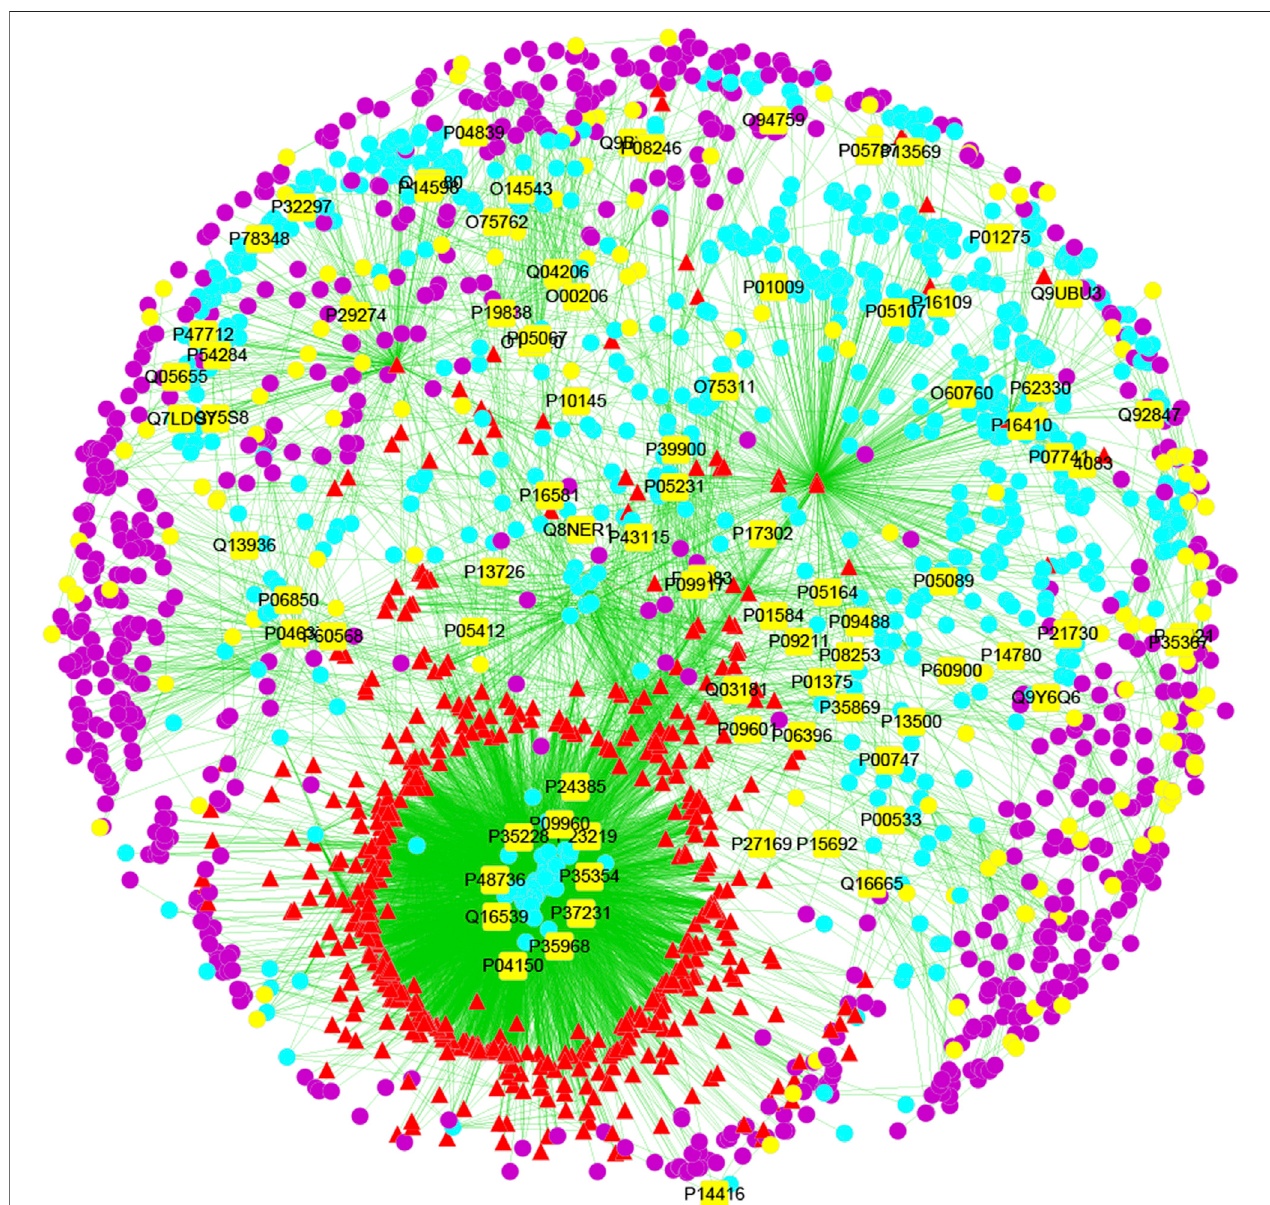
FIGURE 1 | The compound-target-disease interaction network of LHQWC for treating in fl ammation. The yellow square represents the joint target of drugs and diseases, which is also the most important direct target protein in treating in fl ammation by LHQWC. Yellow dots represent in fl ammatory targets. The red triangle represents the predicted possible active ingredients in LHQWC. The blue dot represents the target of LHQWC. The purple dots represent the interaction between the target proteins and the active components of LHQWC.